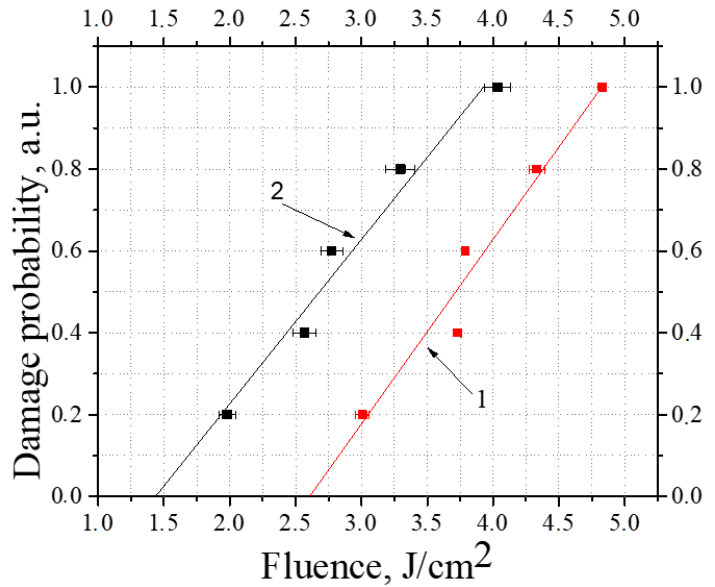
Figure 3. Damage probability vs the laser beam fluence for the ZnSe samples hot isostatically pressed (HIPed) at different temperatures: ZnSe_HIP_1200 (1), ZnSe_HIP_900 (2). The PRR of the Ho 3+ :YAG laser was 12 kHz, the exposure duration was 1 s.